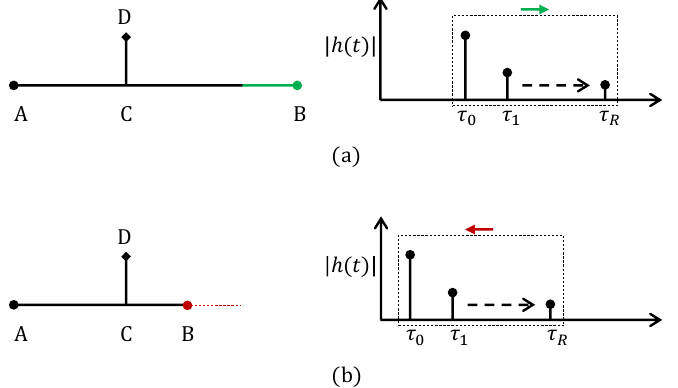
Figure 3. CIR for ( a ) increase and ( b ) decrease in distance between the transmitter and receiver.